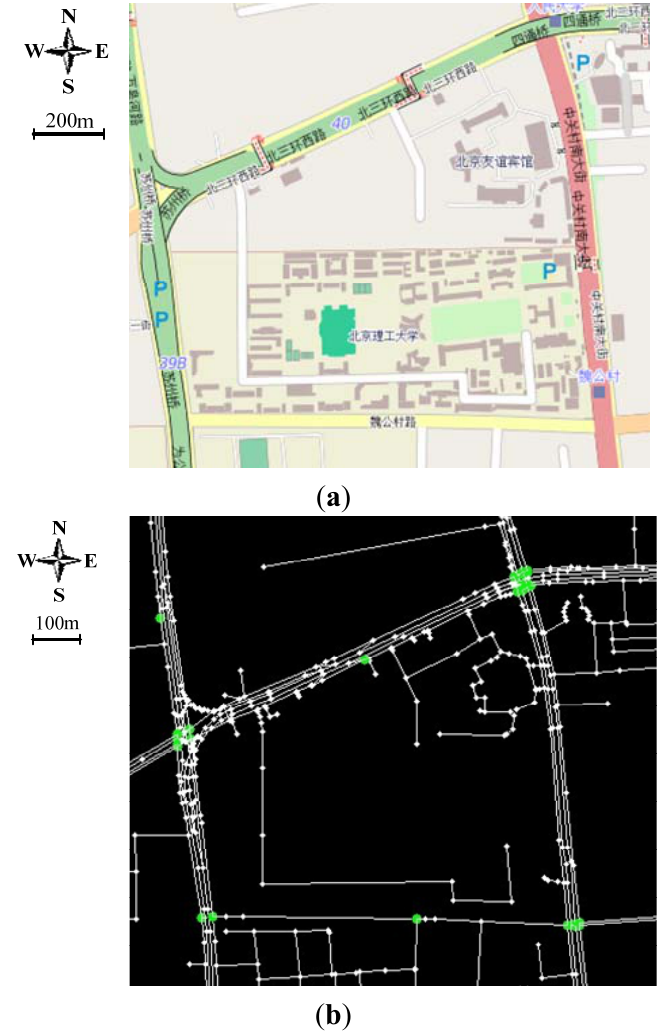
Figure 4. Illustration of building topological map by OpenStreetMap (OSM). ( a ) Urban scenario. ( b ) Corresponding topological map extracted from the OSM. Nodes can provide GPS data, and highlighted green notes are intersections. White lines show roads between connected